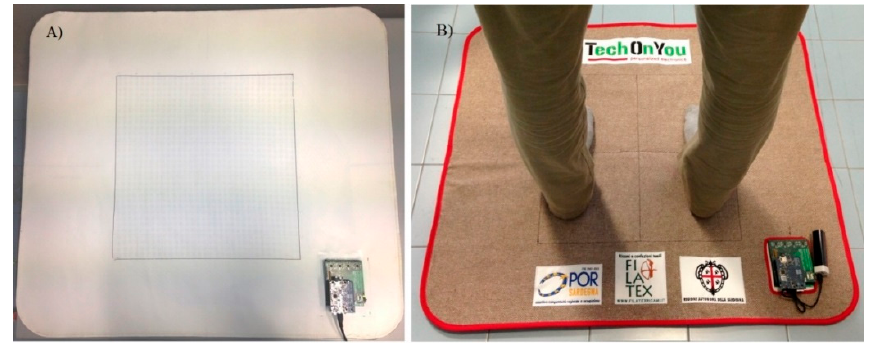
Figure 4. Photograph of the pressure mapping mat prototype with ( A ) impermeable cover only and ( B ) colored cotton cover.